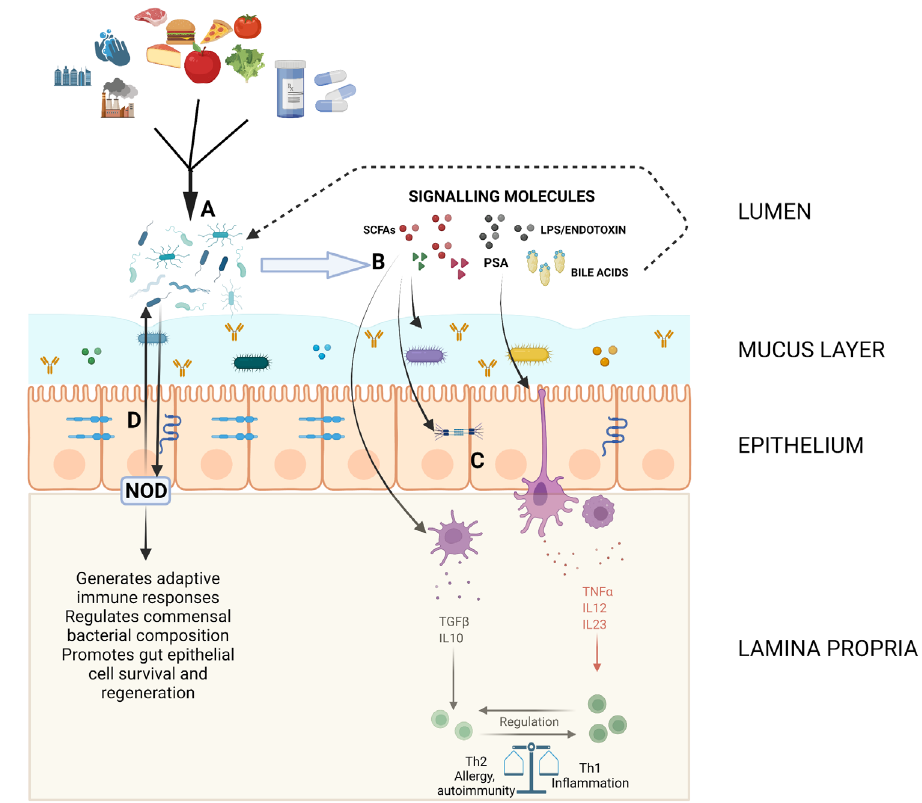
Figure 1. Diagram showing some of the important pathways and interactions in maintaining gut homeostasis. The mucous layer containing soluble IgA, antimicrobial peptides and some commensal organisms as well as the epithelial layer with proteins forming various intercellular junctions composes the structural barrier controlling the interaction between luminal contents and immune components. (A) Environmental and dietary factors influence the composition of the gut microbiome; (B and C) the microbiome produces or alters a variety of signaling molecules including SCFAs, LPS/endotoxin, PSA and bile acids which regulate intestinal barrier function and modulate innate immune responses which eventually lead to downstream shifts in adaptive immune function; (D) bacterial sensing molecules such as NOD molecules interact with and regulate commensal bacteria. Created with BioRender.com. LPS: lipopolysaccharide; NOD: nucleotide-binding oligomerization domain; PSA: polysaccharide A; SCFAs: short chain fatty acids; TGFβ: transforming growth factor β; TNFα: tumor necrosis factor